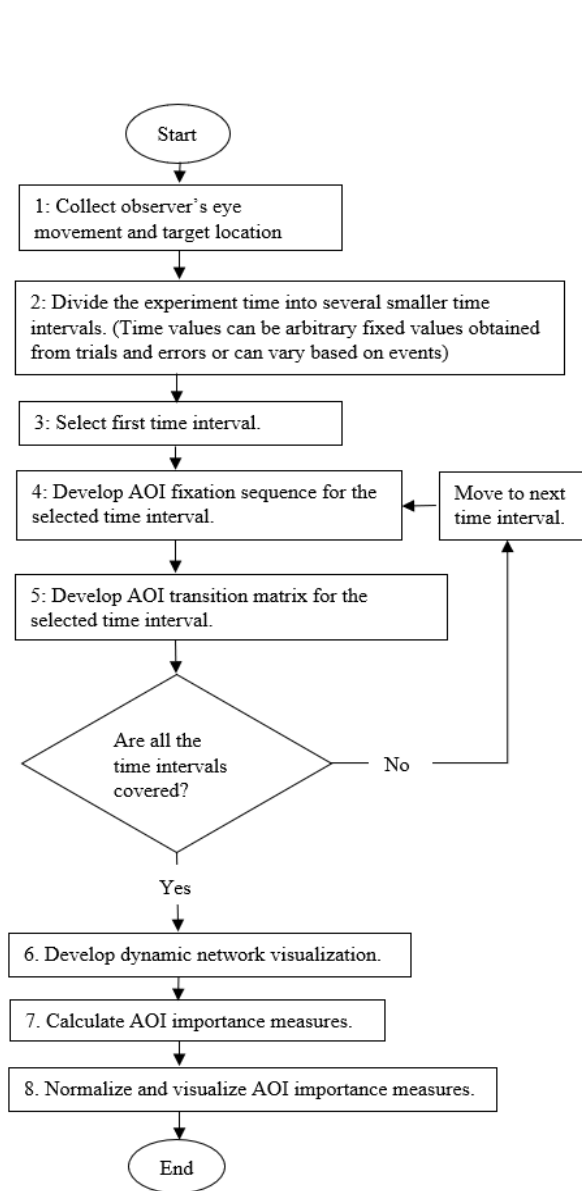
Figure 2. Flowchart showing the various steps of the proposed methodology for analyzing time interval based EM